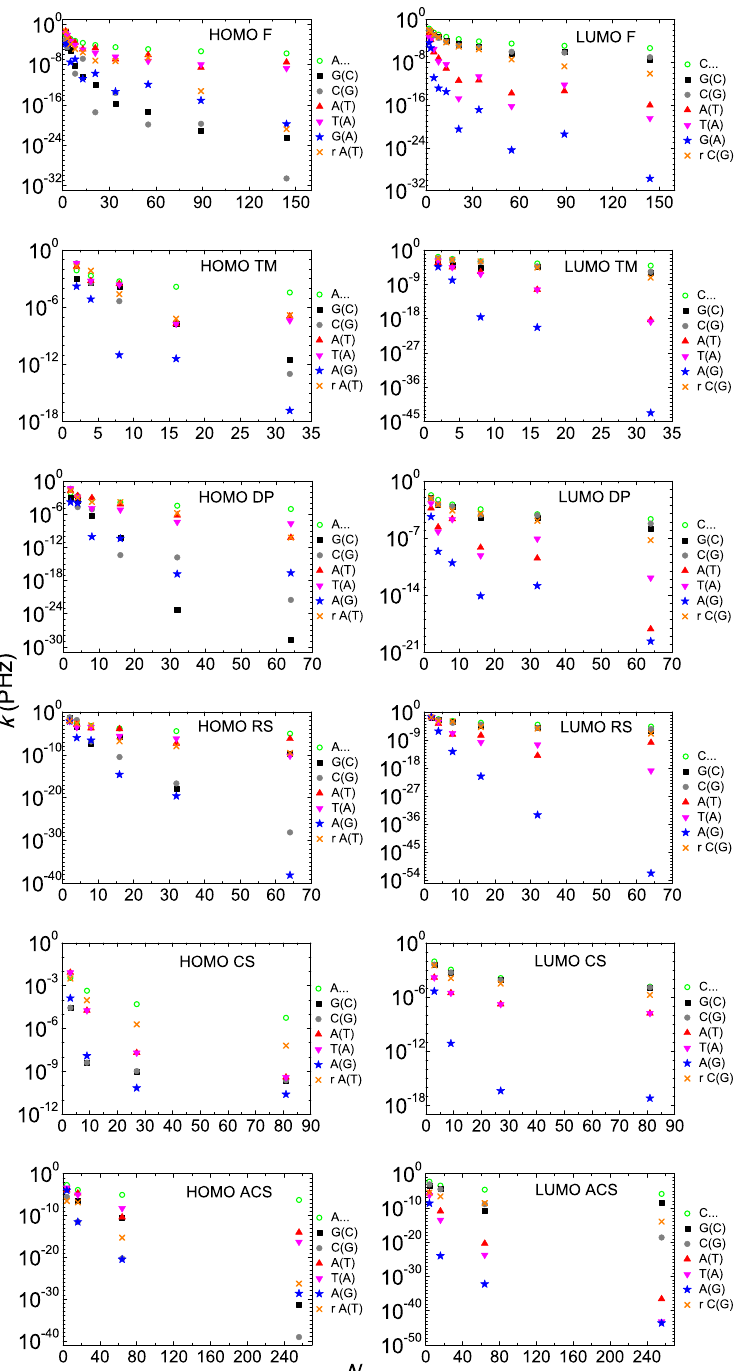
Figure 10. Pure mean transfer rates k of Fibonacci, Thue–Morse, Double Period, Rudin–Shapiro, Cantor Set, Asymmetric Cantor Set polymers, homopolymers and randomly shuffled aperiodic polymers as a function of the number of monomers N in the polymer, for the HOMO (left column) regime and the LUMO (right column) regime. The blue stars denote the D Polymers, i.e., made of different monomers. The notation of polymers is given in Table